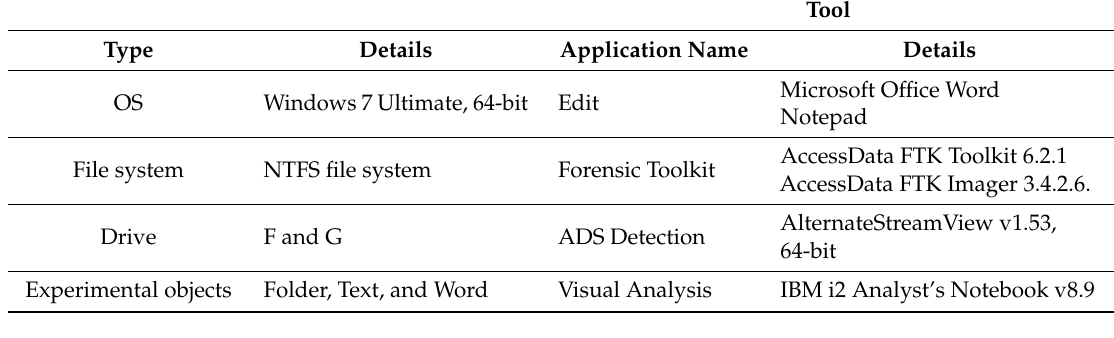
Table 4. Experimental environment.